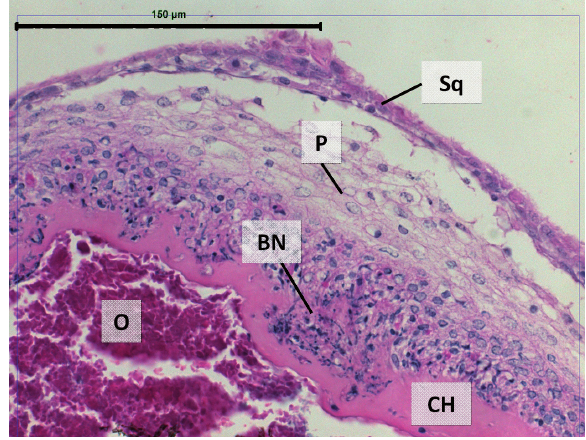
Fig. 2 . – Stratified squamous epithelium structure of a cyst. Sq, sq- uamous cells; P, epithelial cells with vesiculous nucleus; CH, cho- rion; BN, necrotic cells with hyperchromatic nucleus; O, ooplasm. Scale bar=150 μm